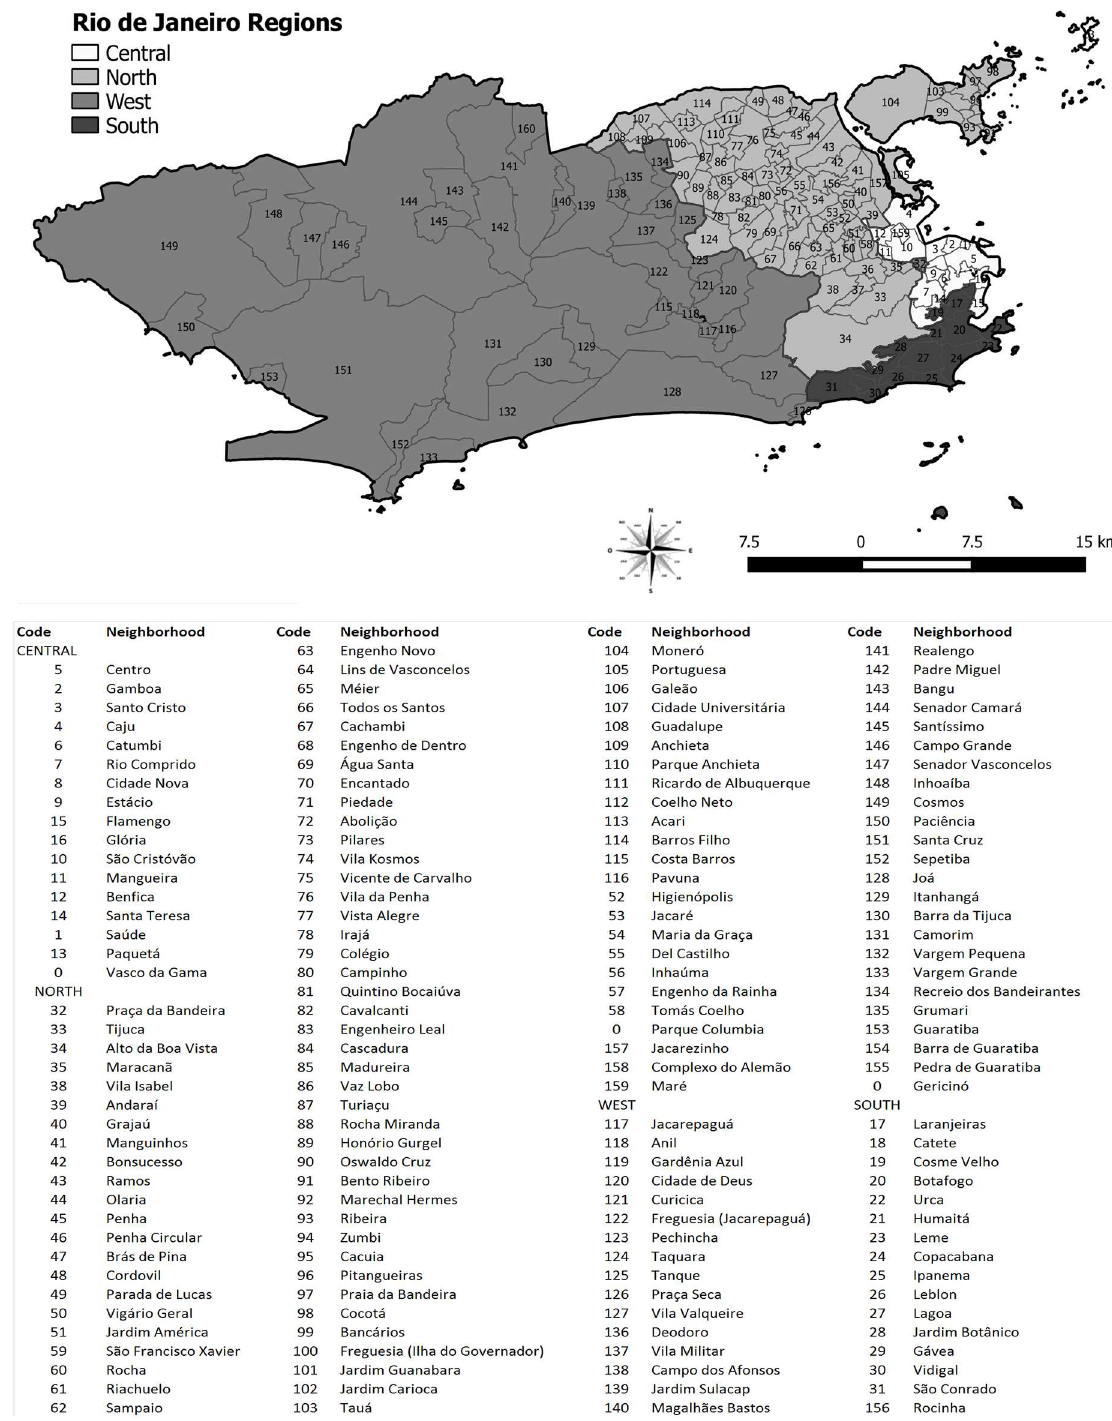
Fig 1. Regions and neighborhoods of the municipality of Rio de